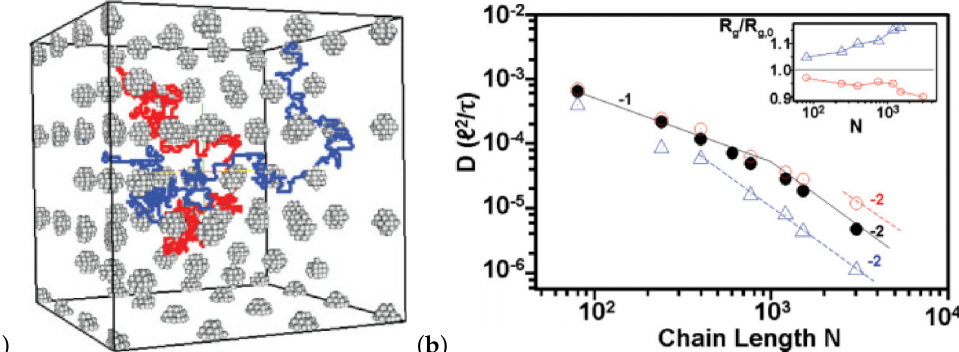
Figure 9. ( a ) Model picture of a nanocomposite system, with nanoparticles of radius R = 2 σ (where σ is the length of a chain segment) in a body-centered cubic configuration with periodic boundary conditions. ( b ) Dependence of D on chain length N in the presence of different particles, at different nanoparticle volume fractions φ : φ = 30% of small particles of radius R = 2 σ (upper triangles), φ = 40% of large particles with radius R = 22 σ (open circles), and pure melt (filled circles). Reprinted from [145] with permission from